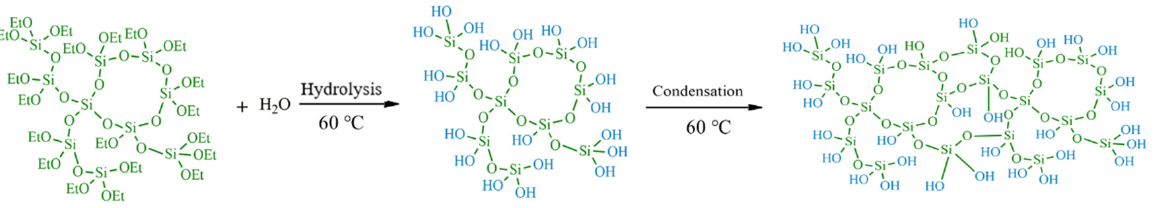
Figure 3. The hydrolysis and condensation reactions of PEOS for synthesis of silica shell (Et- = CH 3 CH 2 -).